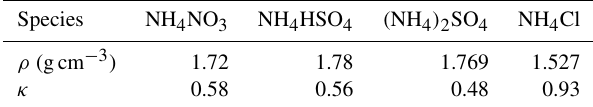
Table 1. Densities ( ρ ) and hygroscopicity parameters ( κ ) of inor- ganic salts used in this